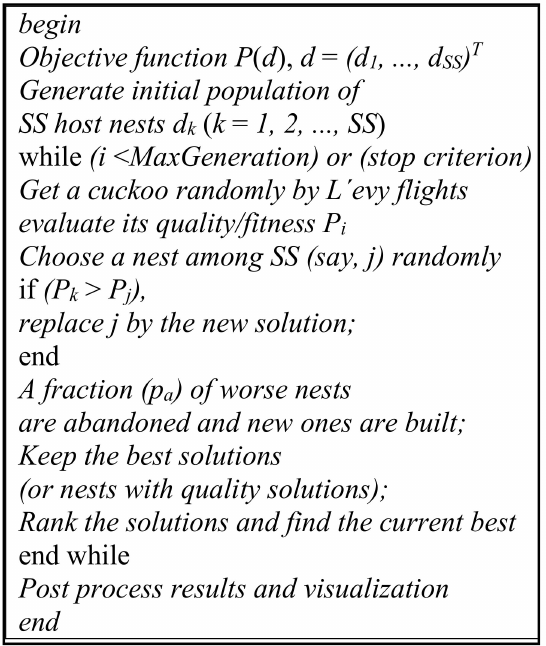
Figure 4. The pseudo code of classical cuckoo search (CCS) algorithm [6].